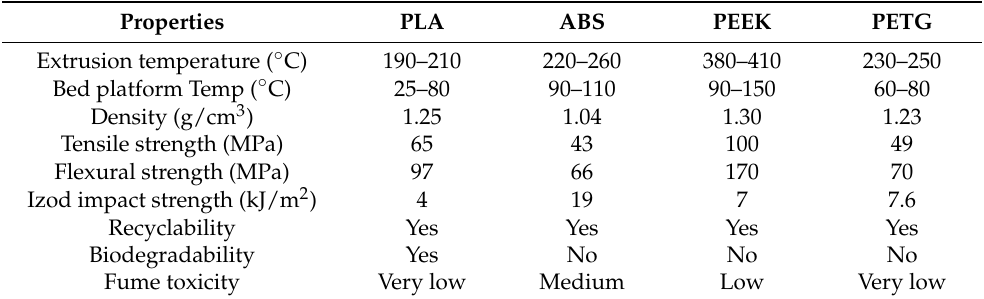
Table 1. Mechanical properties and printing characteristics of different FDM materials. Properties PLA ABS PEEK